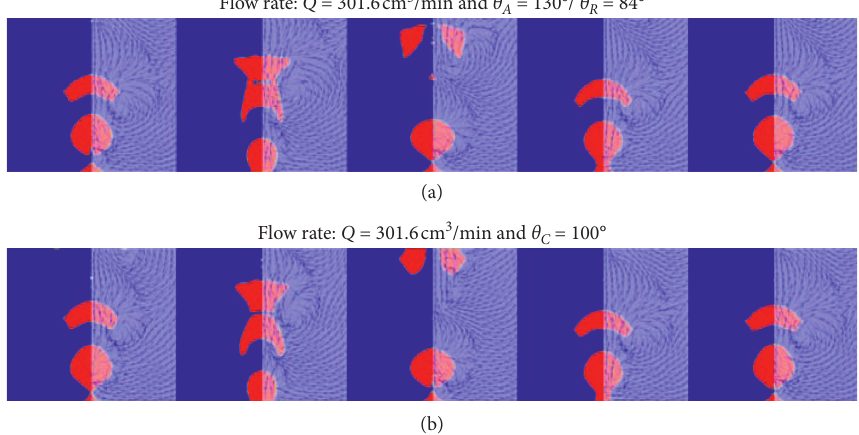
Figure 8: Comparison of flow field between dynamic and static contact angle ( Q � 301.6cm 3 /min, Re � 109.54, and d by using the dynamic contact angle model; (b) flow field by using the static contact angle